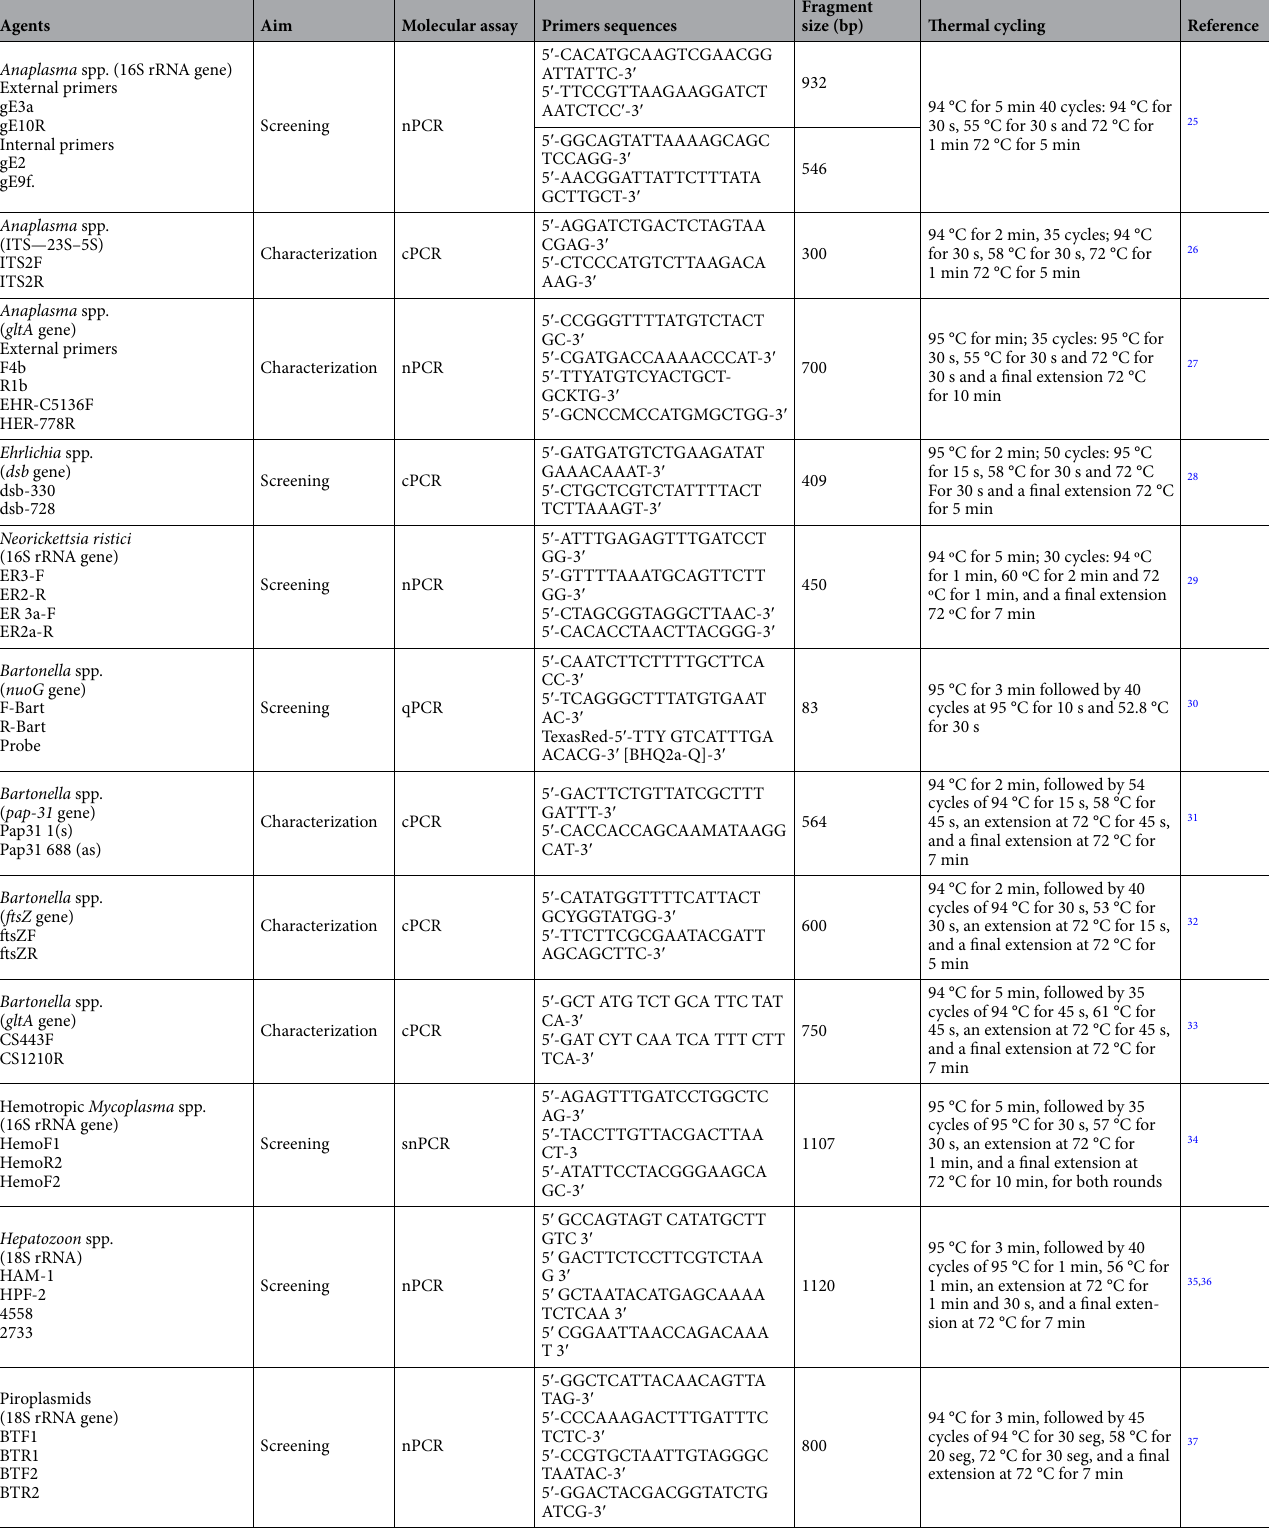
Table 1. Molecular assays according to the involved agent, type of PCR, target gene, primer sequences, size of the amplicons (bp), thermal cycling conditions and references, used in the present study for screening and characterizing vector-borne agents DNA in coati’ blood sampled in Iguaçu National Park, Paraná state, southern